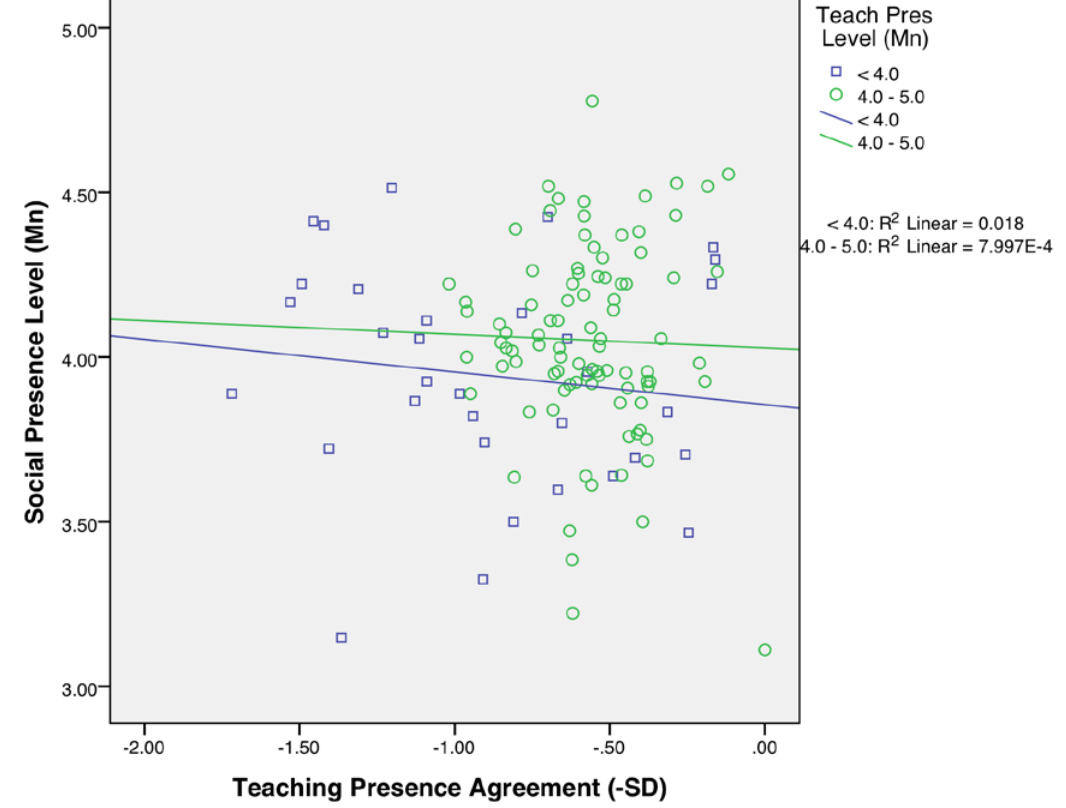
Figure 2 . Effect of teaching presence agreement on social presence level by teaching presence